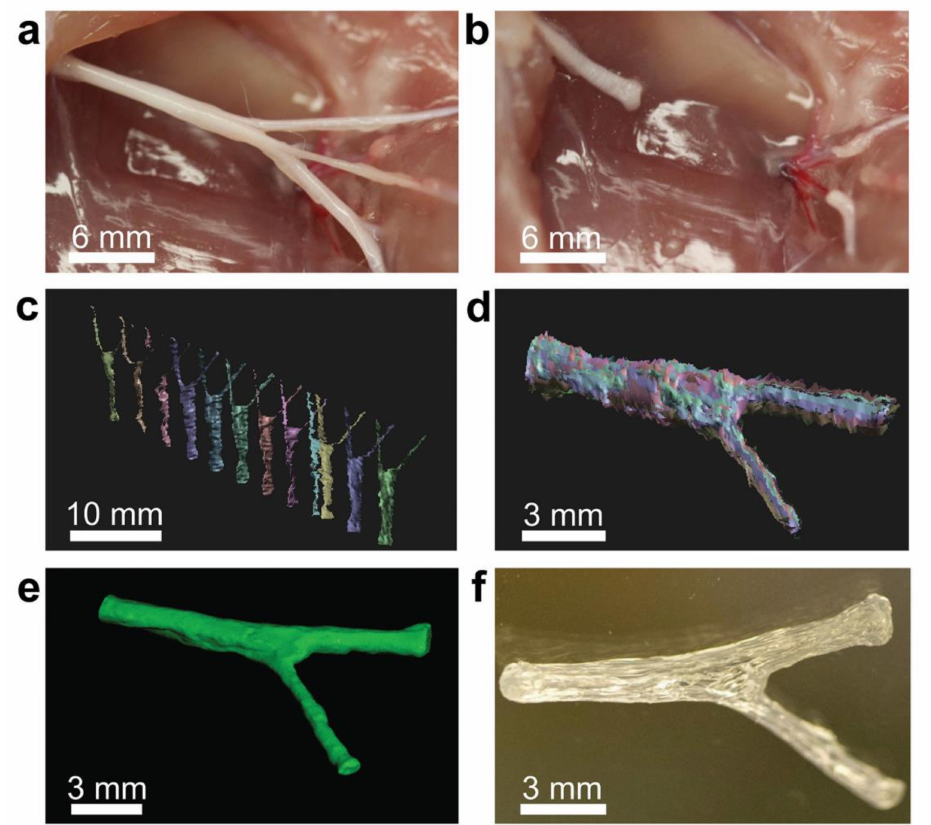
Figure 9. Sciatic nerve map of a rat by extrusion printing. ( a ) The sciatic nerve provides a bifurcating mixed nerve model which contains branching sensory (derived from the sural nerve; top) and motor nerves (derived from the peroneal and tibial nerves; bottom). ( b ) The complex nerve pathway is transected, providing a tissue template for ex situ scanning measurements. ( c ) Scans are conducted from various perspectives to assemble a 3D model which describes the geometry of the nerve pathway (sural and tibial nerve motor branches). ( d ) The individual scans are aligned to replicate the 3D geometry of the nerve tissue. ( e ) The aligned scans are assembled into a water-tight 3D model, leading to a full reconstruction of the nerve pathway geometry, which provides a template for 3D